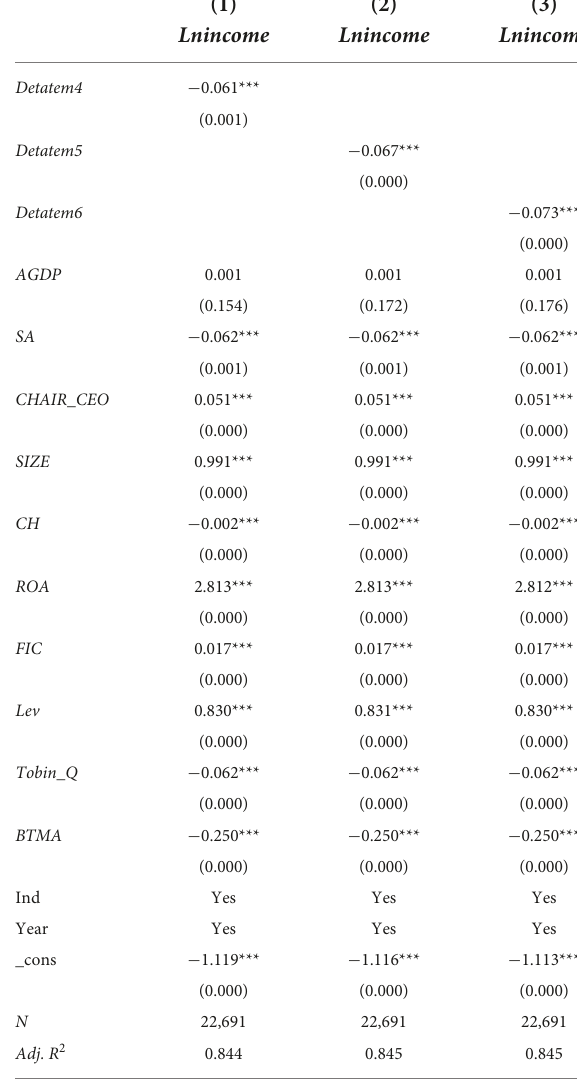
TABLE 7 Impact of temperature variation difference on sales